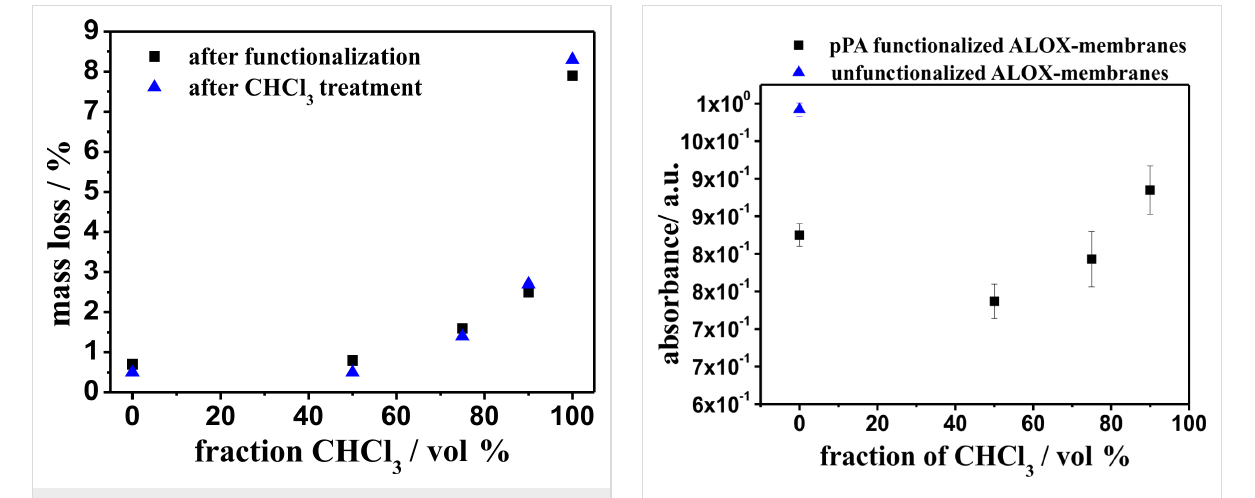
Figure 11: Relative mass loss after heating to 600 °C under air atmo- sphere for different polyphenylalanine functionalized ALOX-mem- branes.